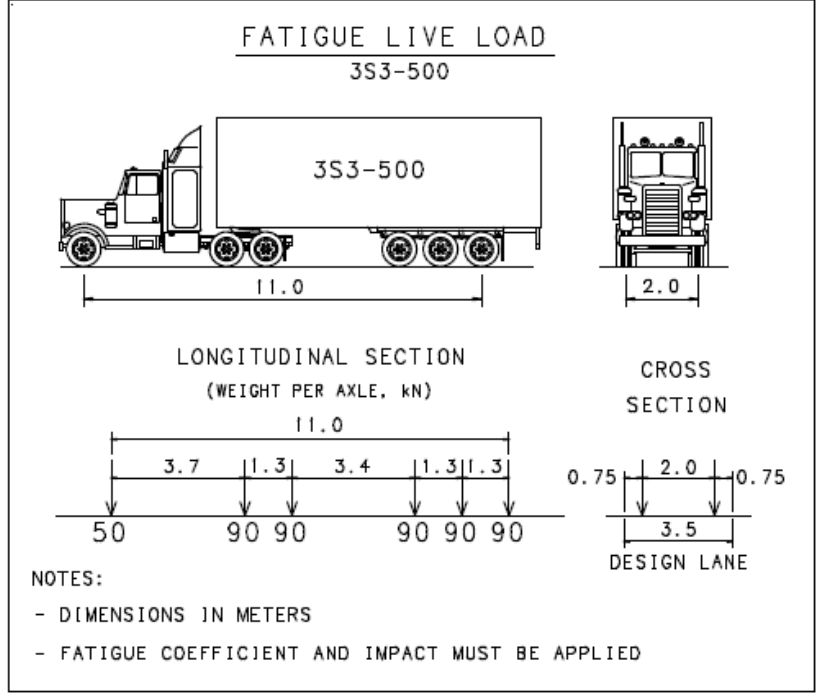
Figure 21. Brazilian live load model proposal for unlimited fatigue life.